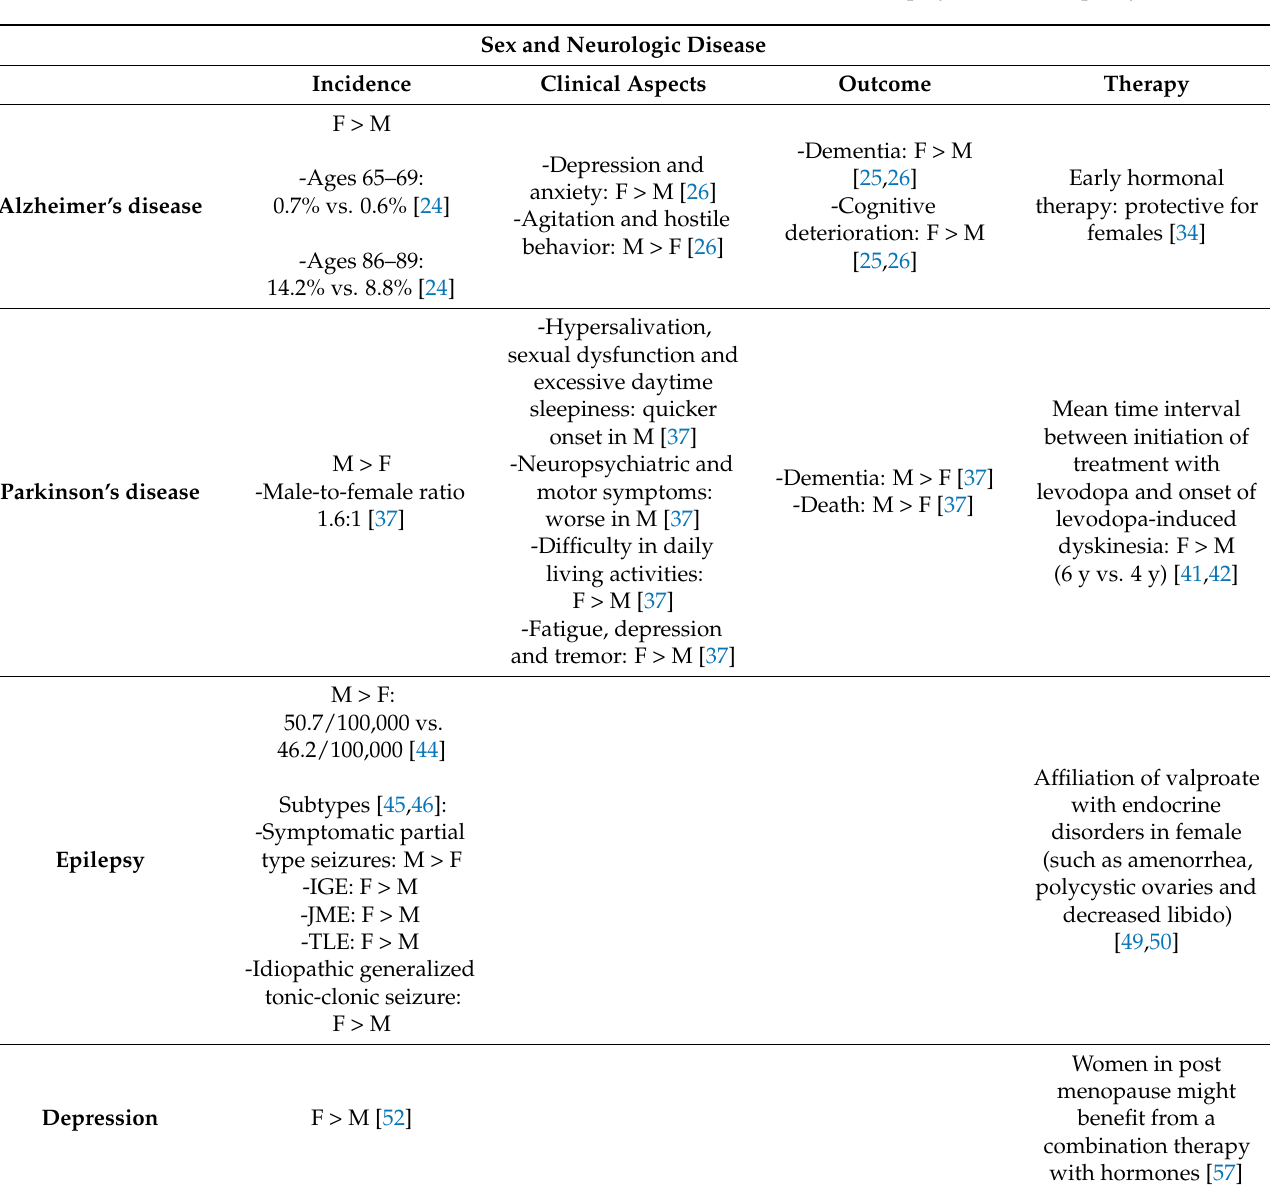
Table 1. Sex differences in neurologic conditions, Comparative data between AD and PD and other diseases described in the text are briefly reported. Note that the incidence, some clinical aspects and the outcome show sex-related differences. Treatments also display some sex